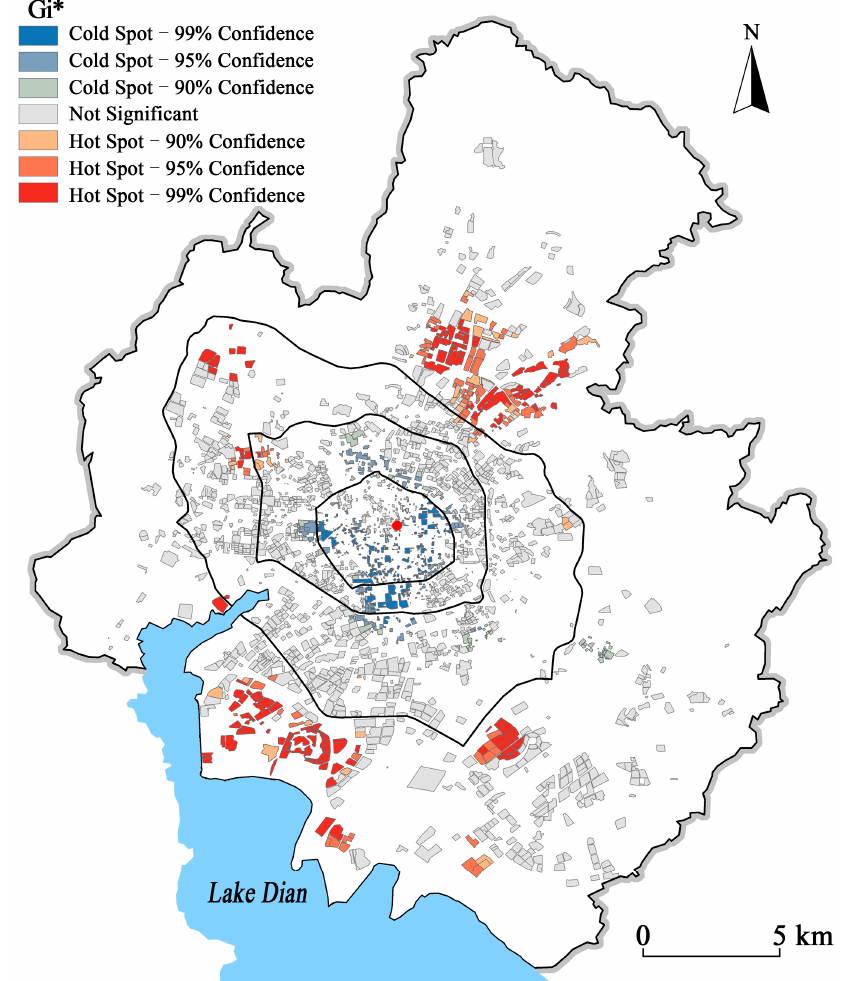
Figure 5. Local spatial analysis of the abandonment degree of the residential quarter in Kunming’s Main Urban District.